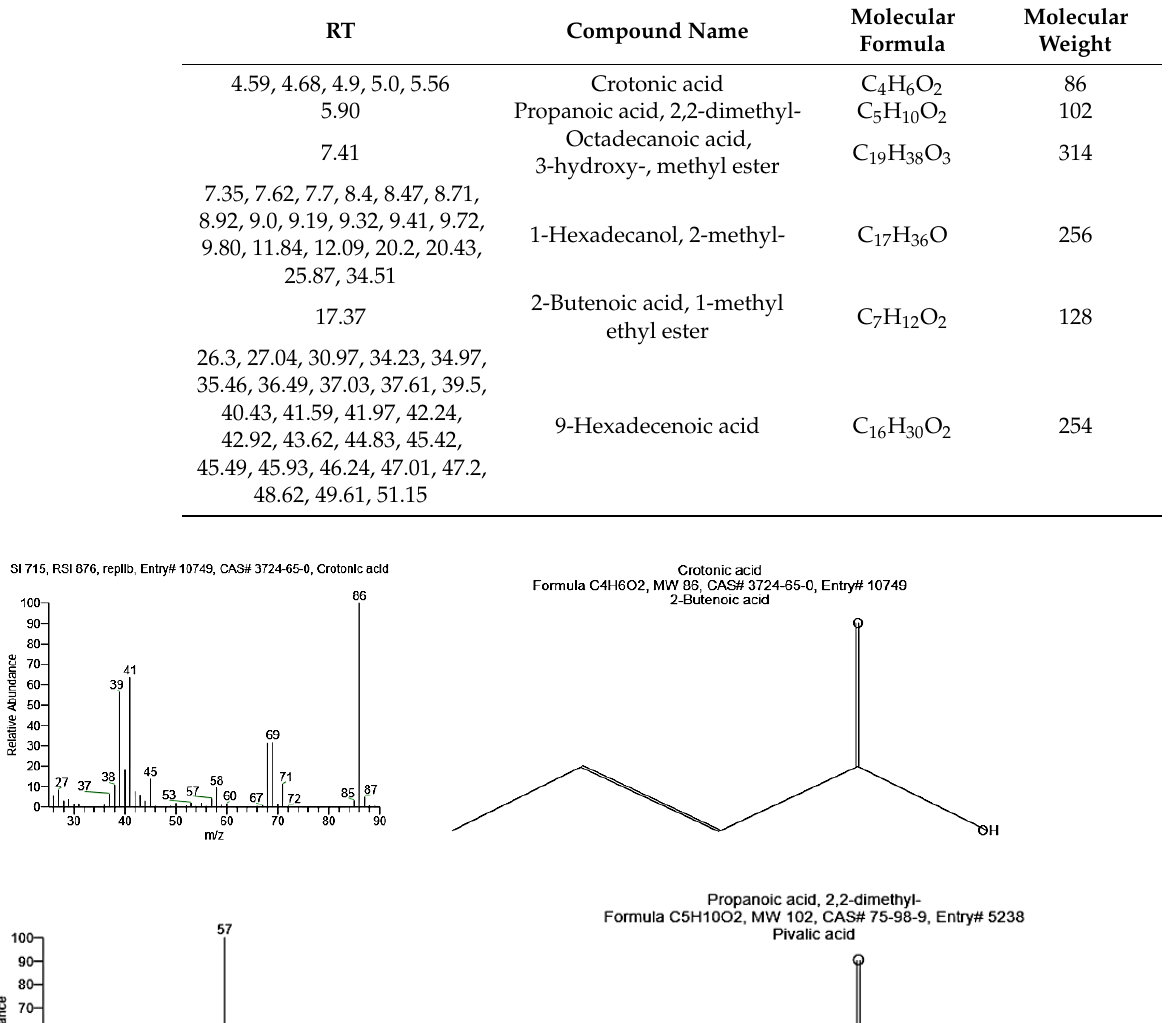
Figure 5. GC-mass spectra of polyhydroxybutyrate (PHB) extracted from Bacillus wiedmannii strain. 3.4. Optimization of Cultural Parameters for Maximum PHB Production 3.4.1. Effect of Incubation Time on PHB Production